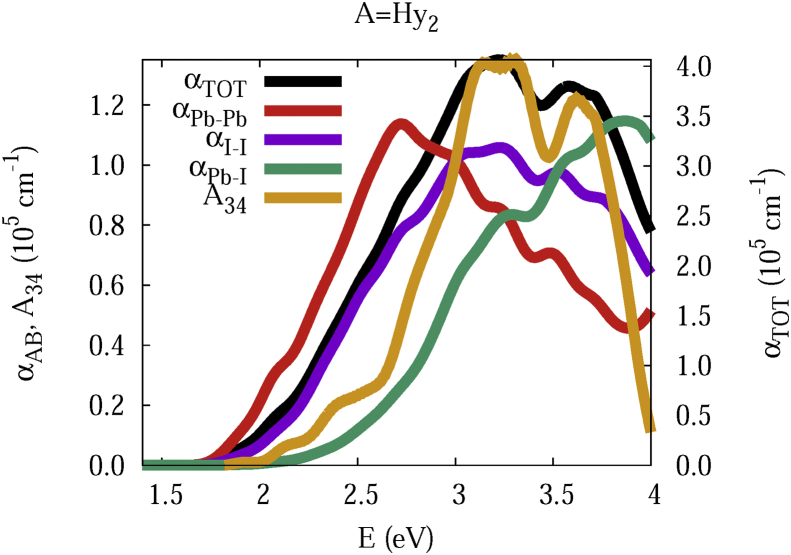
Same legend as that in Fig. 1, but for A = Hy2.